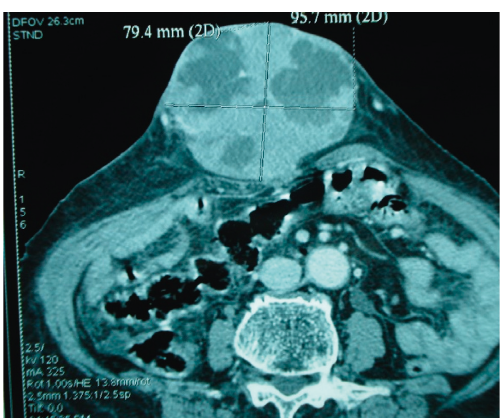
Figure 2: An ovarian tumor with intraperitoneal metastases, one of which extends through a hernial supraumbilical orifice, is shown on a CT scan of the abdominal cavity and pelvis.